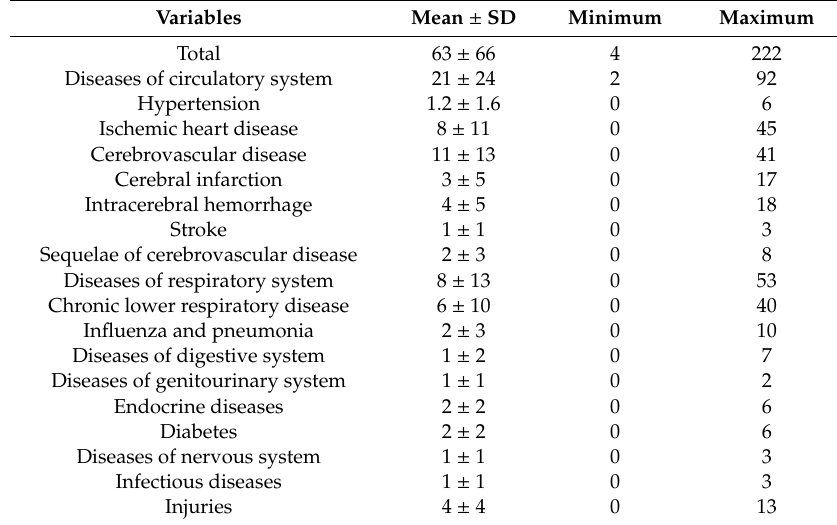
Table 2. Summary of descriptive statistics on average daily cause-specific mortality at 17 study sites in China,